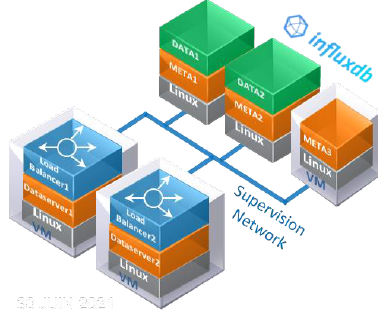
Fig. 5. CAREDAS data archiving.